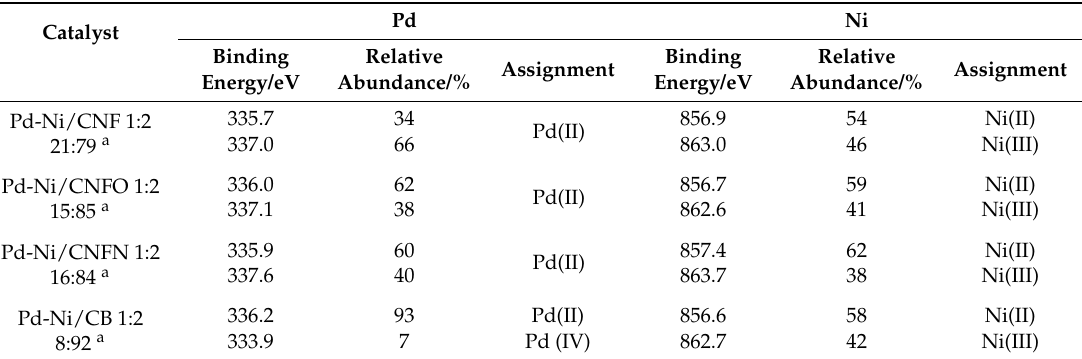
Table 3. Electronic and composition parameters of the Pd ‐ Ni catalysts supported on carbon nanofibers and carbon black, obtained from the X ‐ ray photoelectron spectroscopy (XPS) analysis. Pd Ni Catalyst